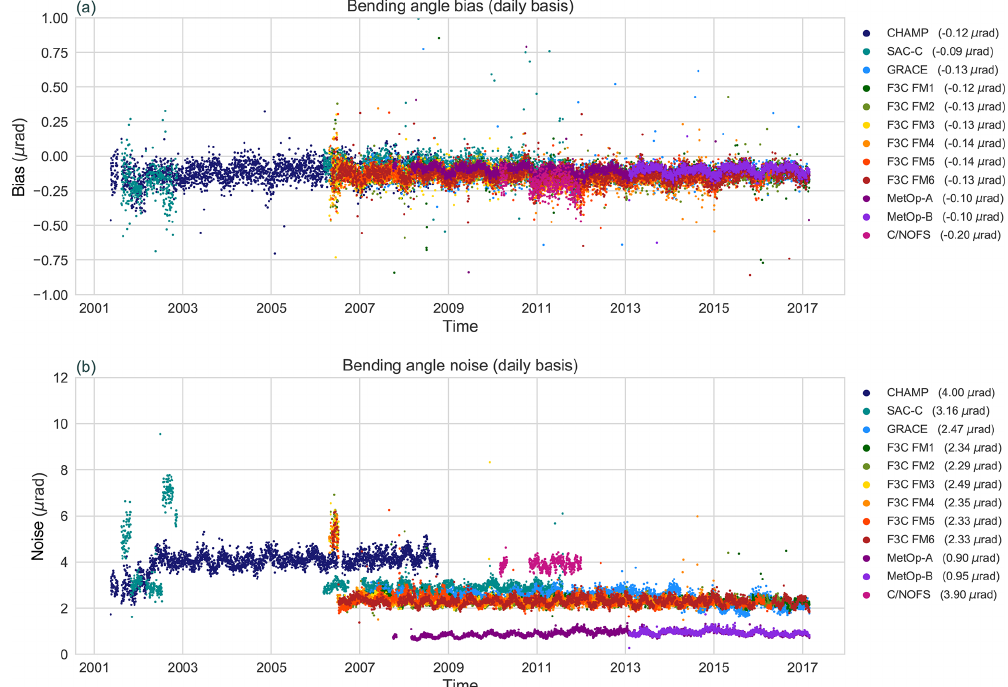
Figure 6. Temporal evolution of daily median bending angle bias (a) and bending angle noise standard deviation (b) for all RO missions used in OPSv5.6. Total mean of bending angle bias and noise is shown as a value in parentheses in the respective legend. Only high-quality profiles are used in these statistics.